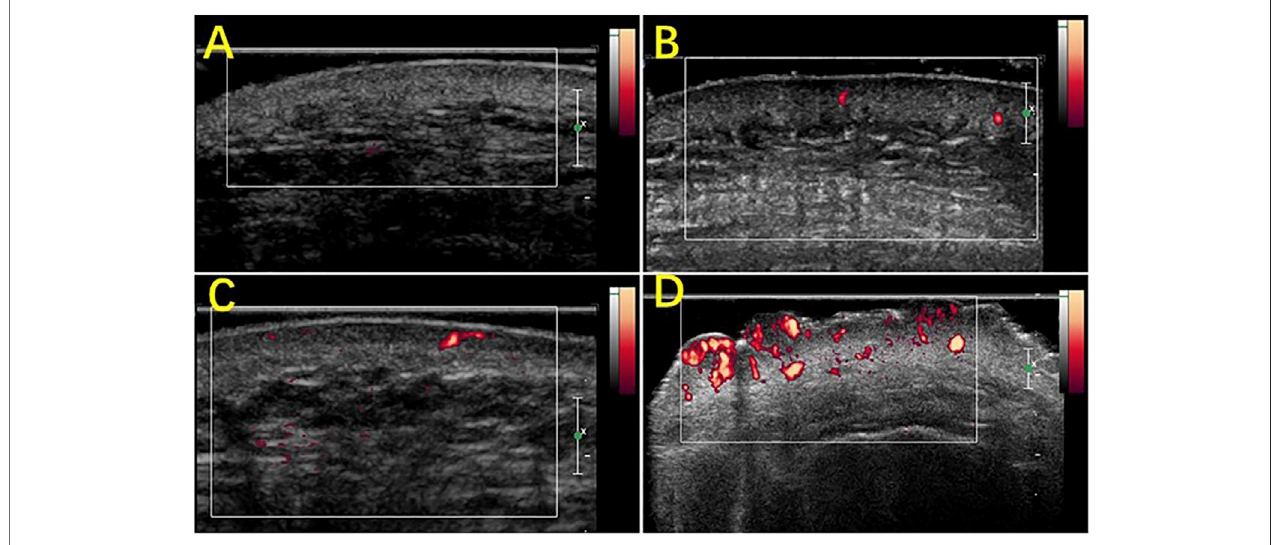
FIGURE4| Scoresoftheblood fl owsignalsinPWSlesionswithPowerDopplerultrasound. (A) Grade0,absenceofcolorsignalsinapink-typelesion; (B) grade1, mild color signals in a thickened-type lesion; (C) grade 2, moderate color signals in a thickened-type lesion; (D) grade 3, marked color signals in a nodular-type lesion.